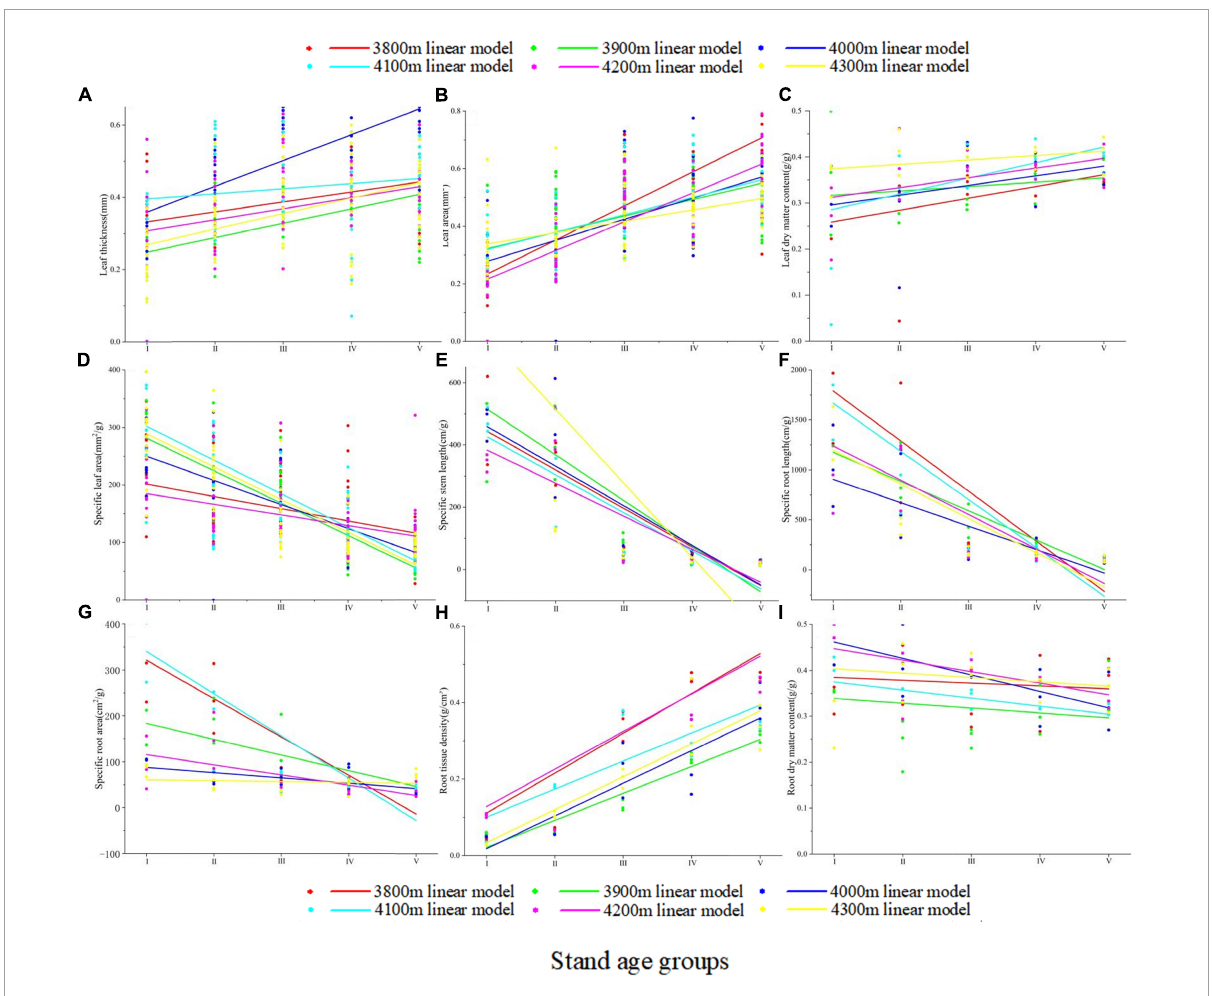
FIGURE2 Variation trends of 9 functional traits over time. Lines represent linear models of seedling traits at each elevation, with colors corresponding to different elevations. (A) Leaf thickness (T); (B) leaf area (LA); (C) leaf dry matter content (LDMC); (D) specific leaf area (SLA); (E) specific stem length (SSL); (F) specific root length (SRL); (G) specific root area (SRA); (H) root tissue density (RTD); (I) root dry matter content (RDMC).